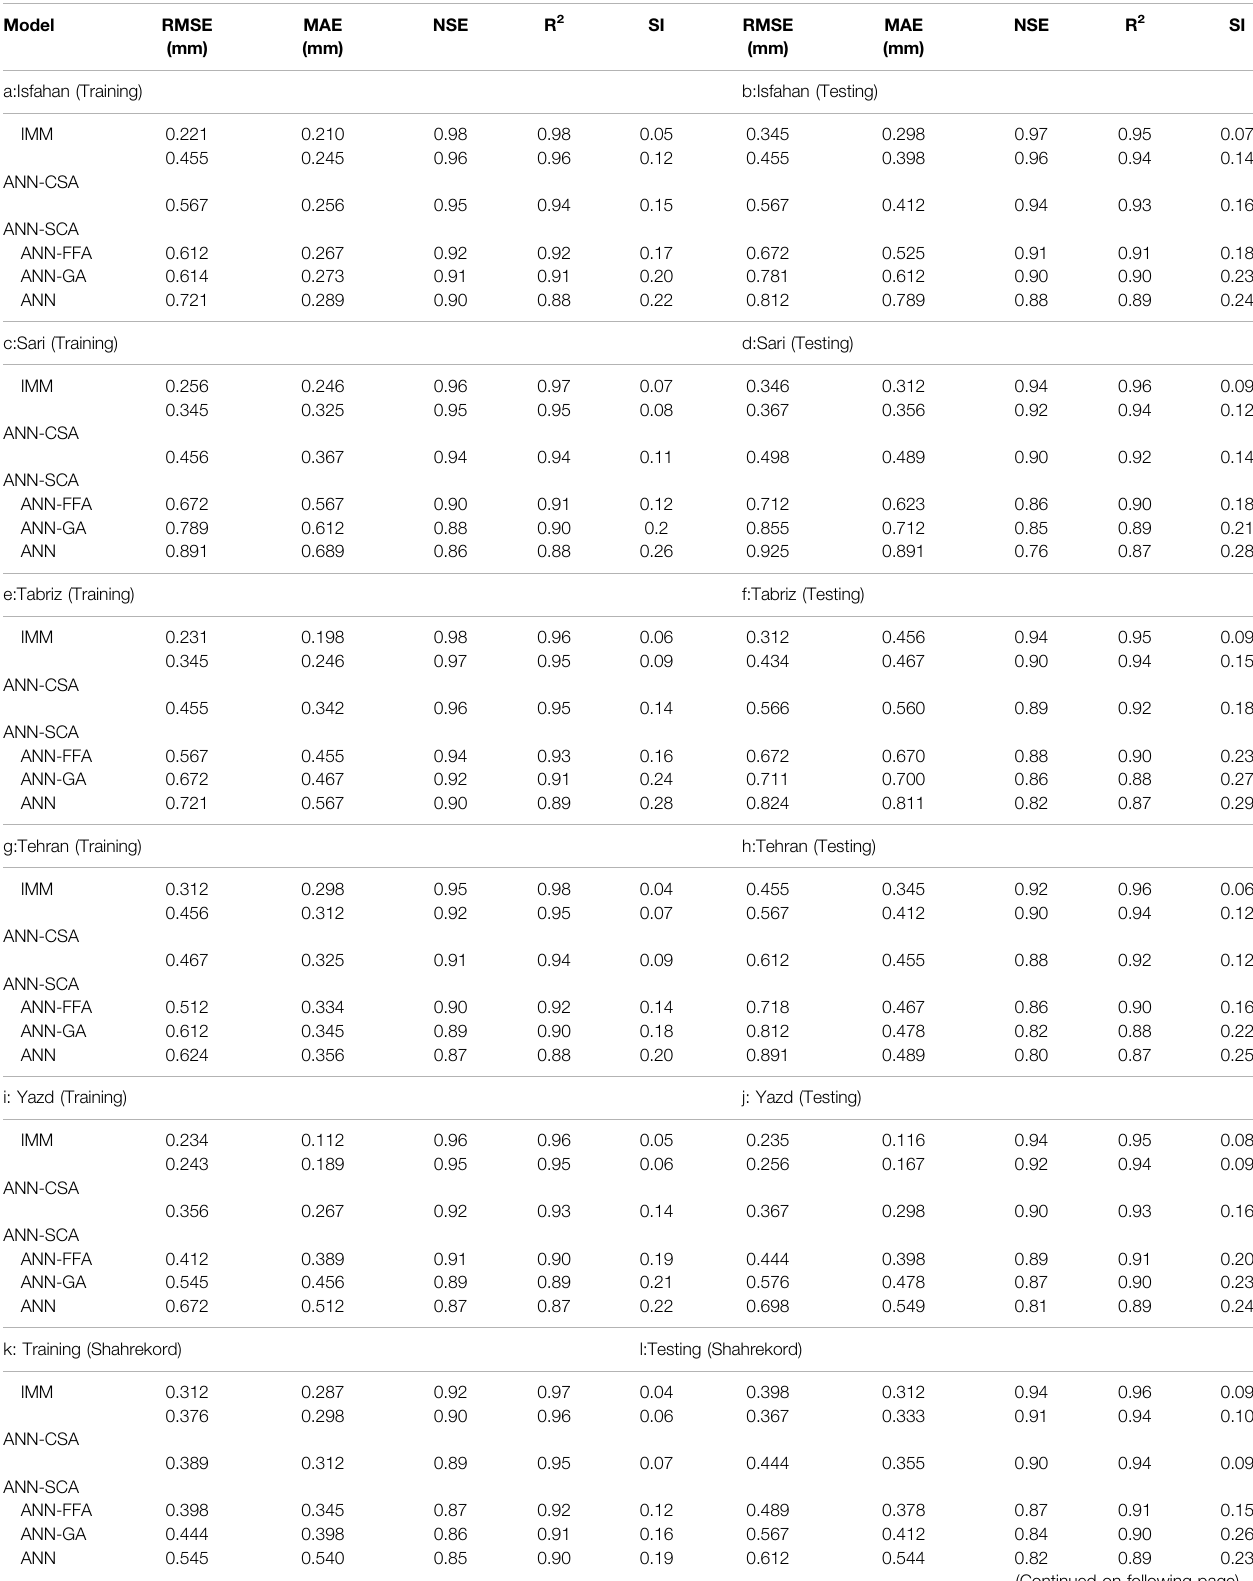
TABLE 4 | Statistical results for different models based on error indexes.